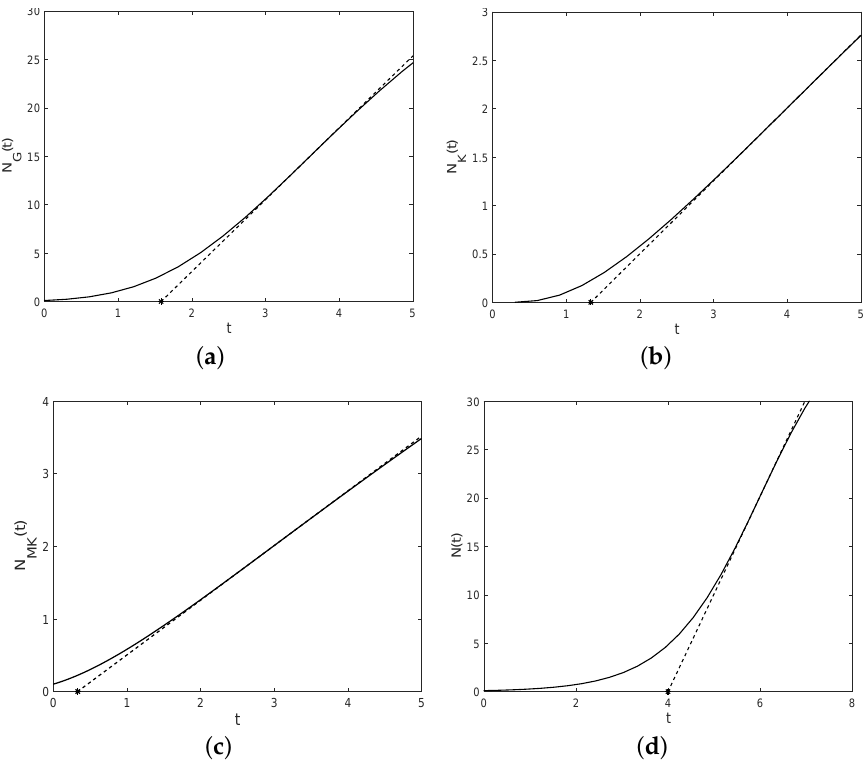
Figure 5. The tangent lines (dashed lines) and the lag times (asterisk points) with y = 0.1, A = 0.1, α = 3, β = 0.5, C = 40.34, and r = 1 for ( a ) Gompertz model, ( b ) Korf model, ( c ) modified Korf model, ( d ) logistic